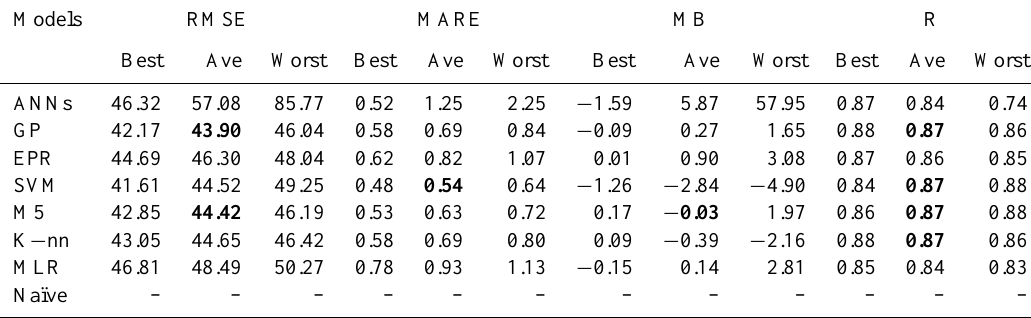
Table 7. Testing results of all models applied to the evapotranspiration dataset. Models